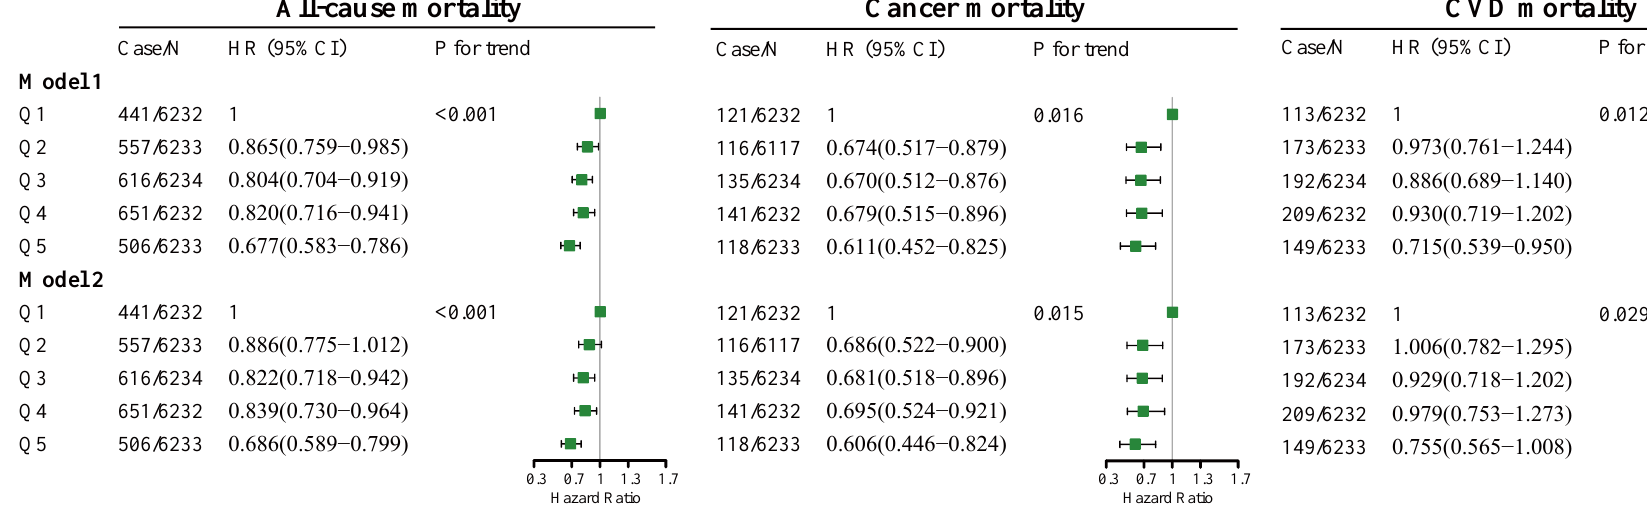
Figure 1. Adjusted HRs for all-cause, cancer, and CVD mortality by quintiles of total dietary fiber intake. Model 1 adjustments include age (5 categories); sex; classification of BMI; ethnicity, income; education level; smoking and drinking status; regular exercise; nutrient supplement use; total intake of energy (10 categories); percentage of energy provided by protein, fat, and carbohydrates; AHEI (10 categories); the prevalence of diabetes, hypertension, and hyperlipidemia; and medication use for glucose or blood pressure or blood lipids. Model 2 is based on model 1, with the additional adjustment of a timing variable. BMI, body mass index; AHEI, Alternative Healthy Eating Index; CVD, cardiovascular disease; Case/ n , number of case participants/total; Q, Quintile; HR, hazard ratio.